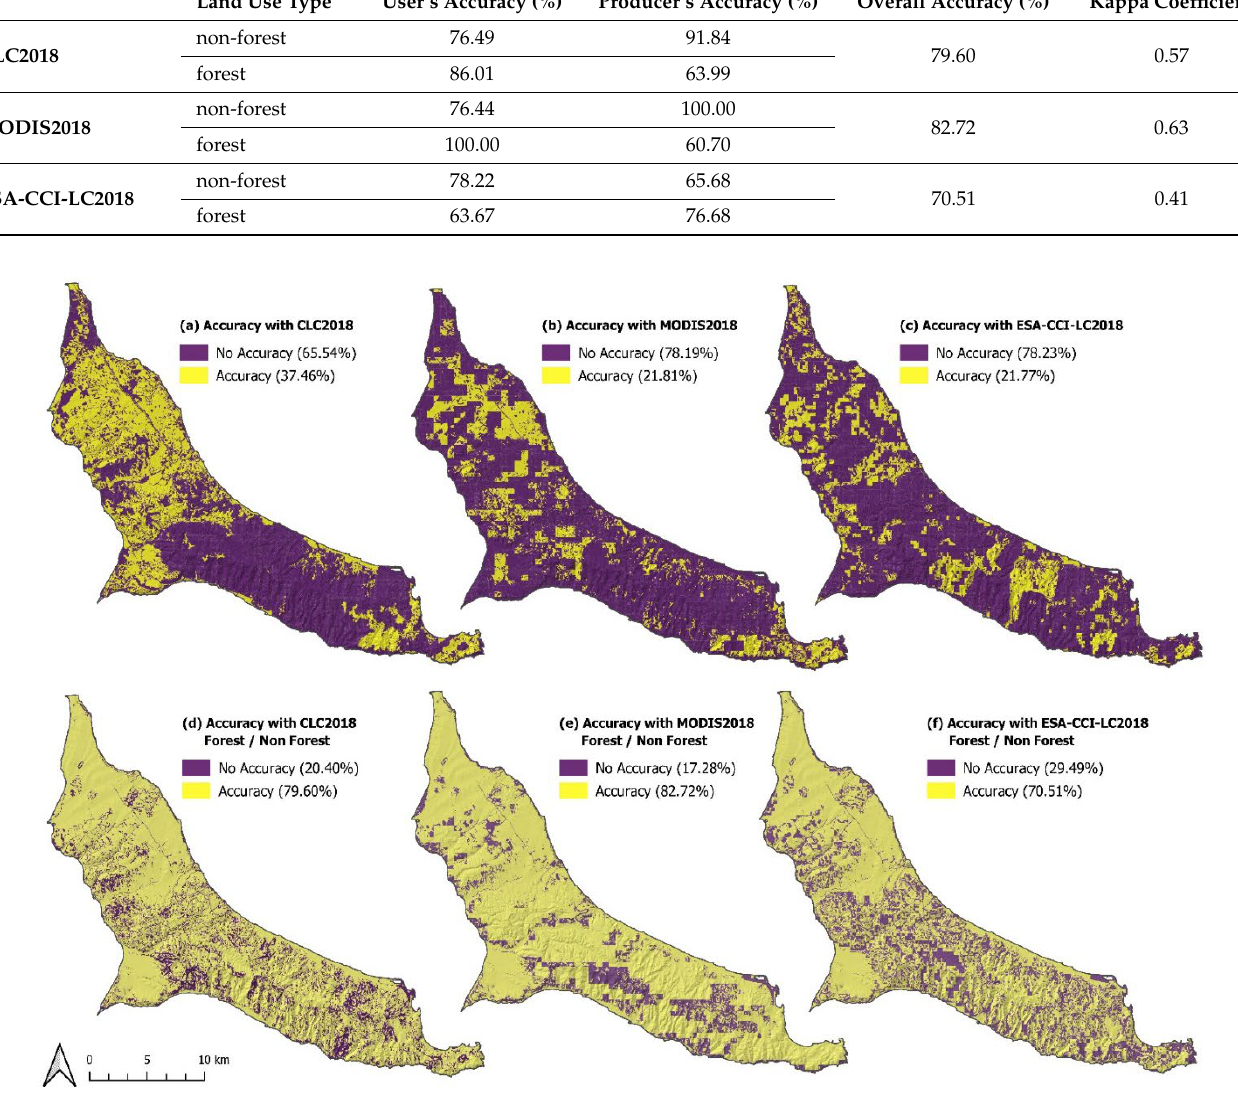
Figure 5. Spatial distribution of the agreement and differences of the total land cover mapping ( a – c ) and of the forest vs. non-forest mapping ( d – f ) between the KASSANDRA DATASET2018 and the three land cover products.